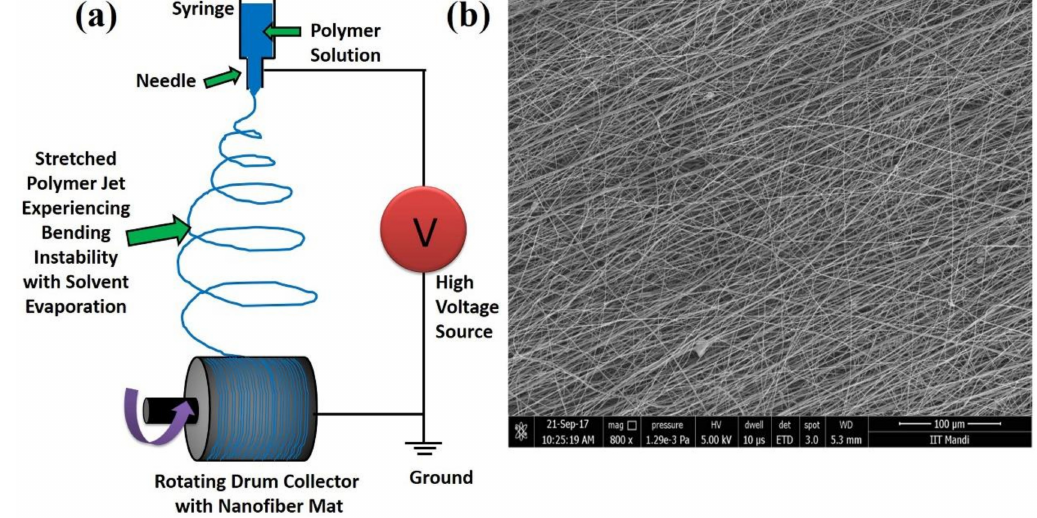
Figure 2. ( a ) Schematic representation of the Electrospinning process and ( b ) electrospun nonwoven mat of Polyacrylonitrile (PAN) from an unpublished work of